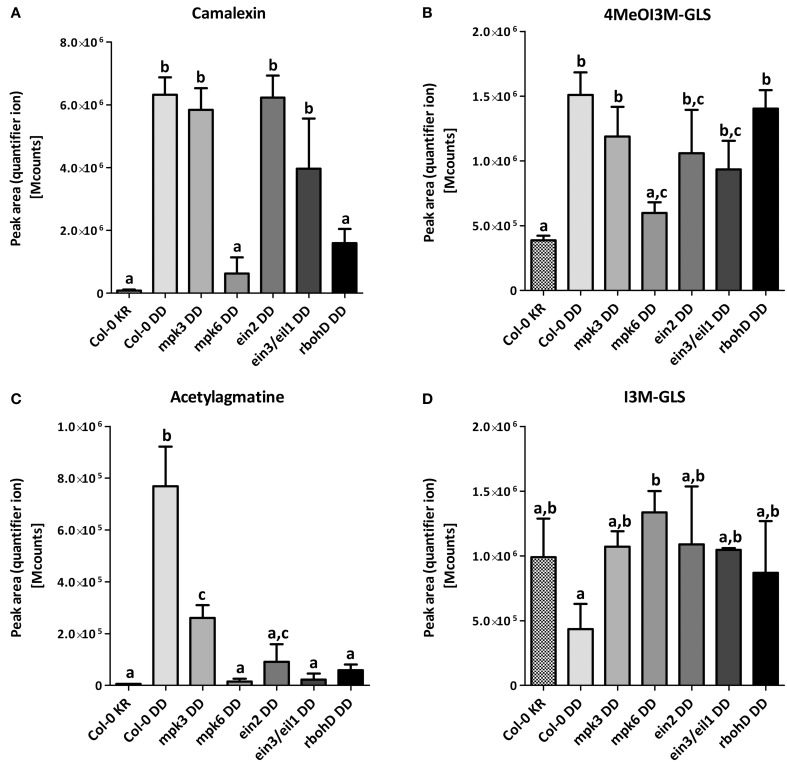
Mutant background influences metabolome modulation. Samples were taken 24 h after DEX treatment in three independent experiments. The peak areas of the quantifier ion (Table S19) for camalexin (A), 4MeOl3M-GLS (B), acetylagmatine (C) and I3M-GLS (D) were determined for relative quantification. Significance of changes was calculated by One-Way ANOVA with Tukey's multiple comparison post-test, where the different alphabets denote statistically distinct groups. Note that in B, the levels of 4MeOI3M-GLS in the mpk6, ein2 or ein3/eil1 mutants are not distinguishable and therefore additionally marked with the letter c.